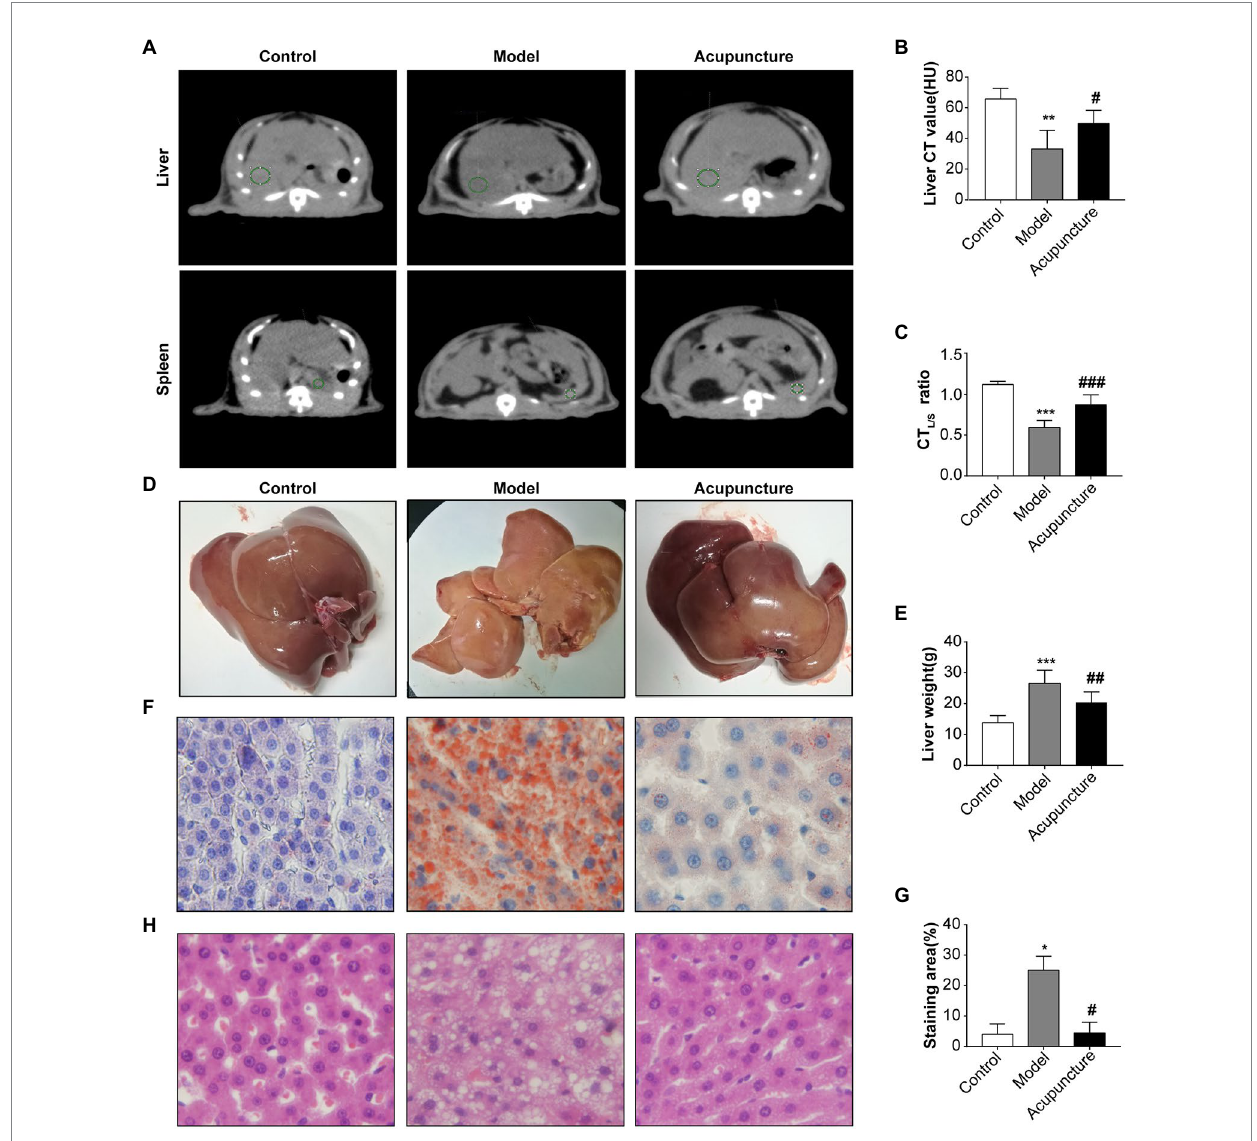
FIGURE 3 Impact of acupuncture on hepatic steatosis in non-alcoholic fatty liver disease (NAFLD) rats. (A) Liver and spleen CT value measurements of liver fat content. QCT films of the liver and spleen of the control, model, and acupuncture groups; green circles indicate regions of interest (ROI) in liver and spleen measurements used to indicate the CT values of the liver and spleen. (B) Liver CT (CT L ) values (HU). (C) Liver to spleen CT ratio (CT L/S ). (D) Fresh liver tissues. (E) Liver weight (g). (F) Oil Red O staining of rat livers (×100). (G) Quantification of the red area/total area by Oil Red O staining. (H) H&E staining of liver tissue (×100). Data are shown as mean ± SD. * p < 0.05, *** p < 0.001, Control vs. Model, # p < 0.05, ## p < 0.01, Model vs.